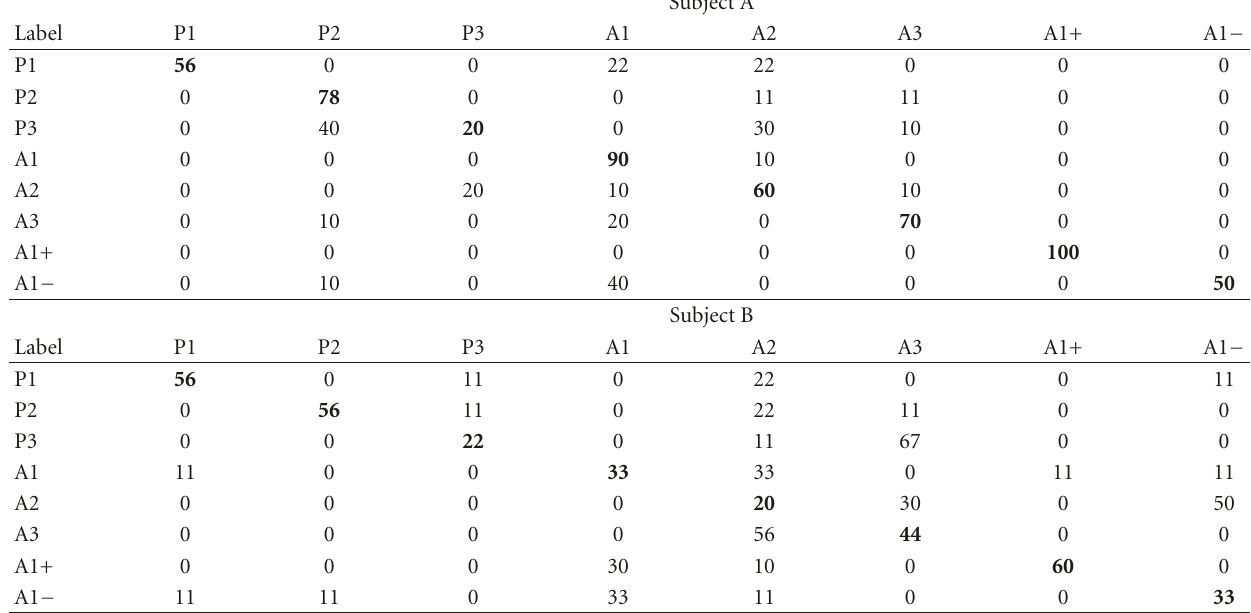
Table 2: Relative classification results for the eight modes of two subjects. Row labels indicate target class and columns the percentage of classifying the claps of target class to all classes. Overall classification rate is 65% for subject A and 41% for subject